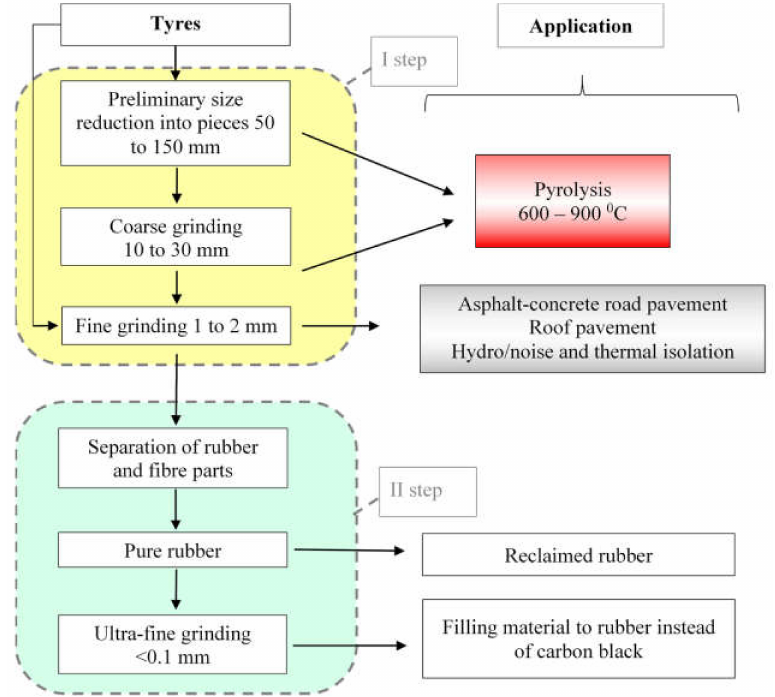
Figure 4. Staged grinding of end-of-life tires indicating the options for use of individual fractions of